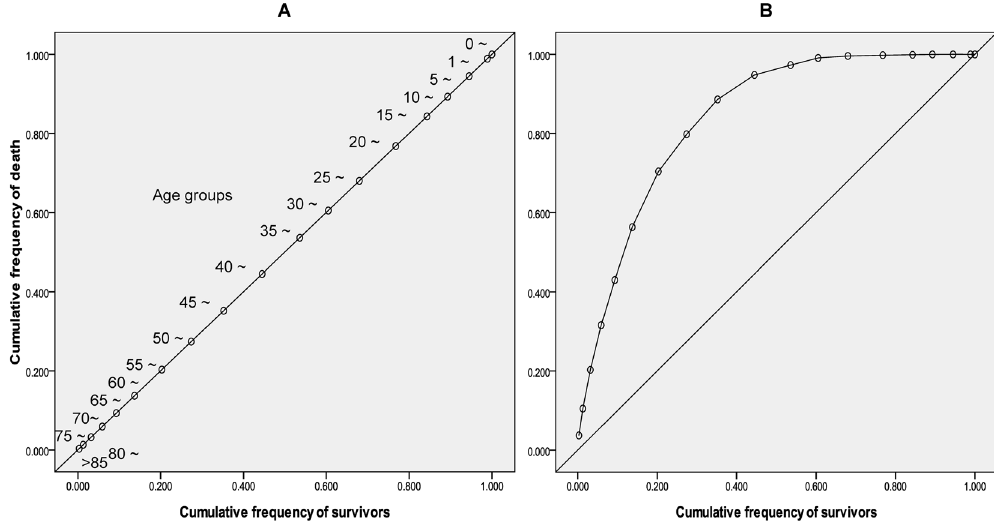
Figure 1. Scatter plot showing the cumulative frequency of survival and the cumulative frequency of death by age group. ( A ) age was not associated with death; ( B ) age had an impact on death from a